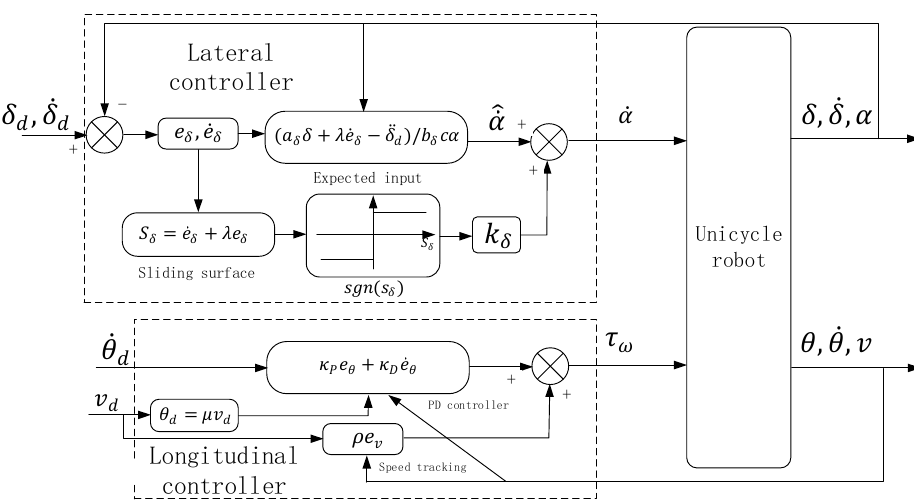
Figure 4. The control block diagram of the unicycle robot.